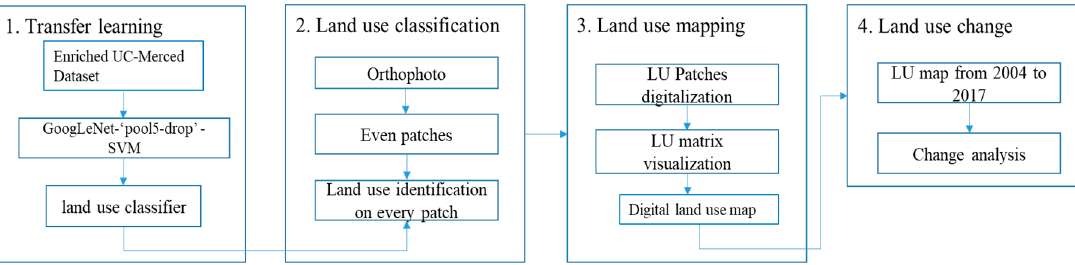
Figure 6. Flowchart of the process for land-use change analysis based on the retrained CNN.